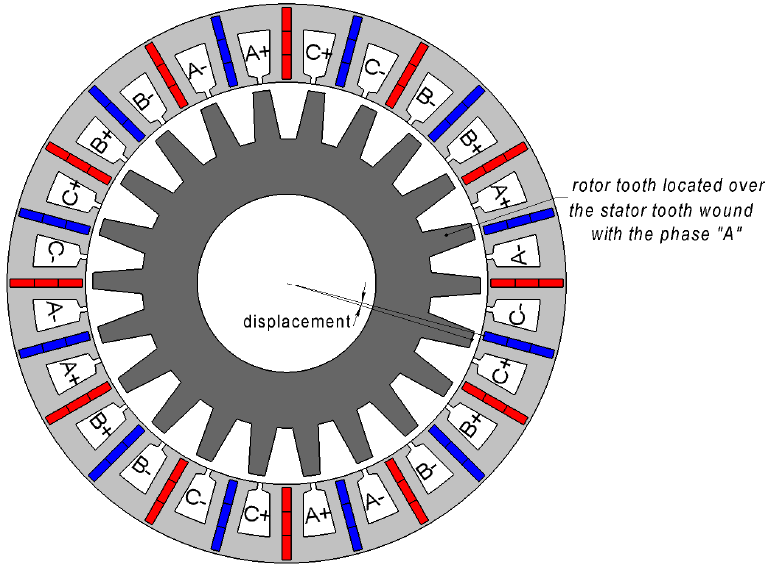
Figure 1. Sketch of the 22/24 flux switching generator (FSG).